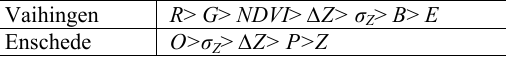
Table 1: Most relevant features for datasets Vaihingen and